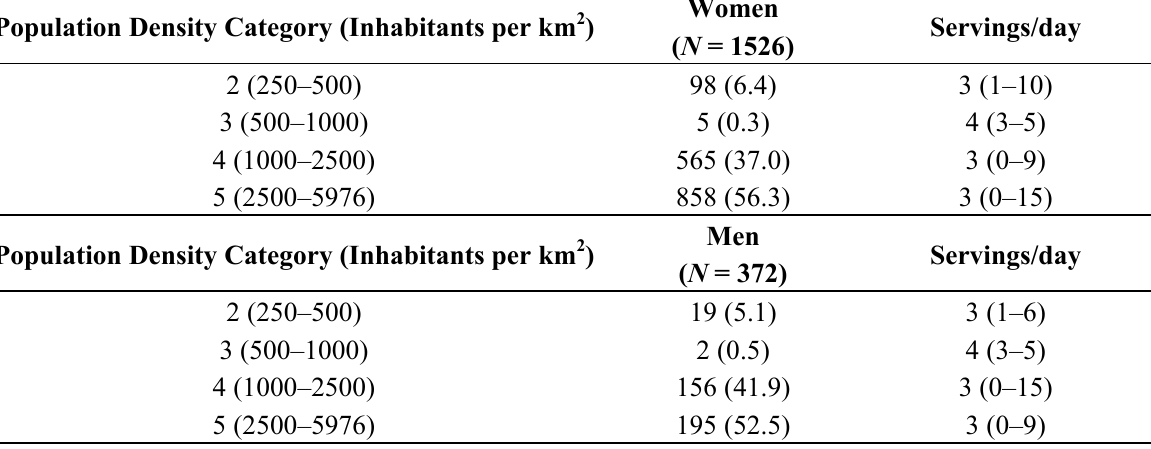
Table 5. Number of daily servings of dairy products in women and men grouped by population